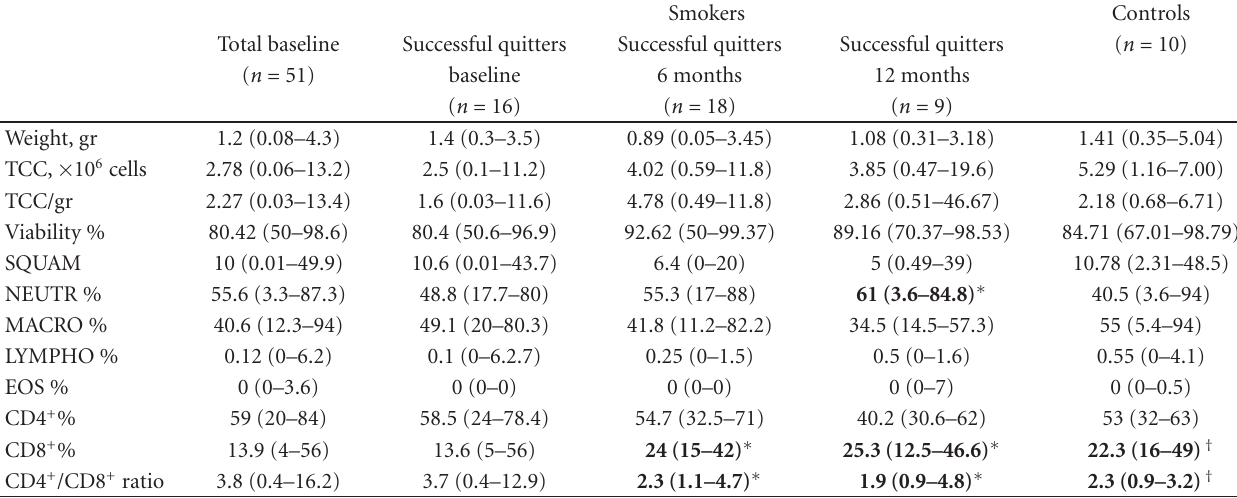
Figure 2: Example of a flow cytometric analysis with dot plots and histograms from a representative sample (from one subject). First, epithelial cells were excluded from the analysis by gating on all CD45 + Fleukocytes (plot (a)). Then lymphocytes were gated by morphology on an FS/SS plot (plot (b)). Finally, CD8 + and CD4 + lymphocytes were gated (plot (c)). Staining of isotype control antibodies is also shown (plot (d)). PE: phycoerythrin, PC-5: phycoerythrin-cyanine, FITC: fluorescein isothiocyanate. Table 2: Sputum di ff erential cell counts and lymphocyte